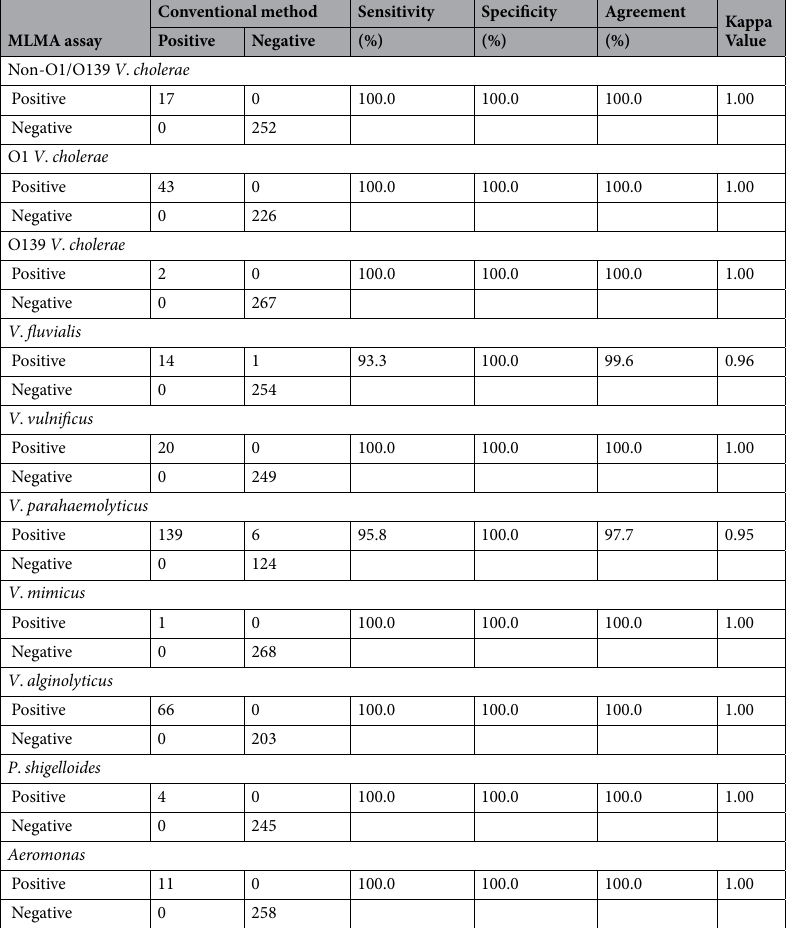
Table 3. Performance of the MLMA assay compared with the conventional